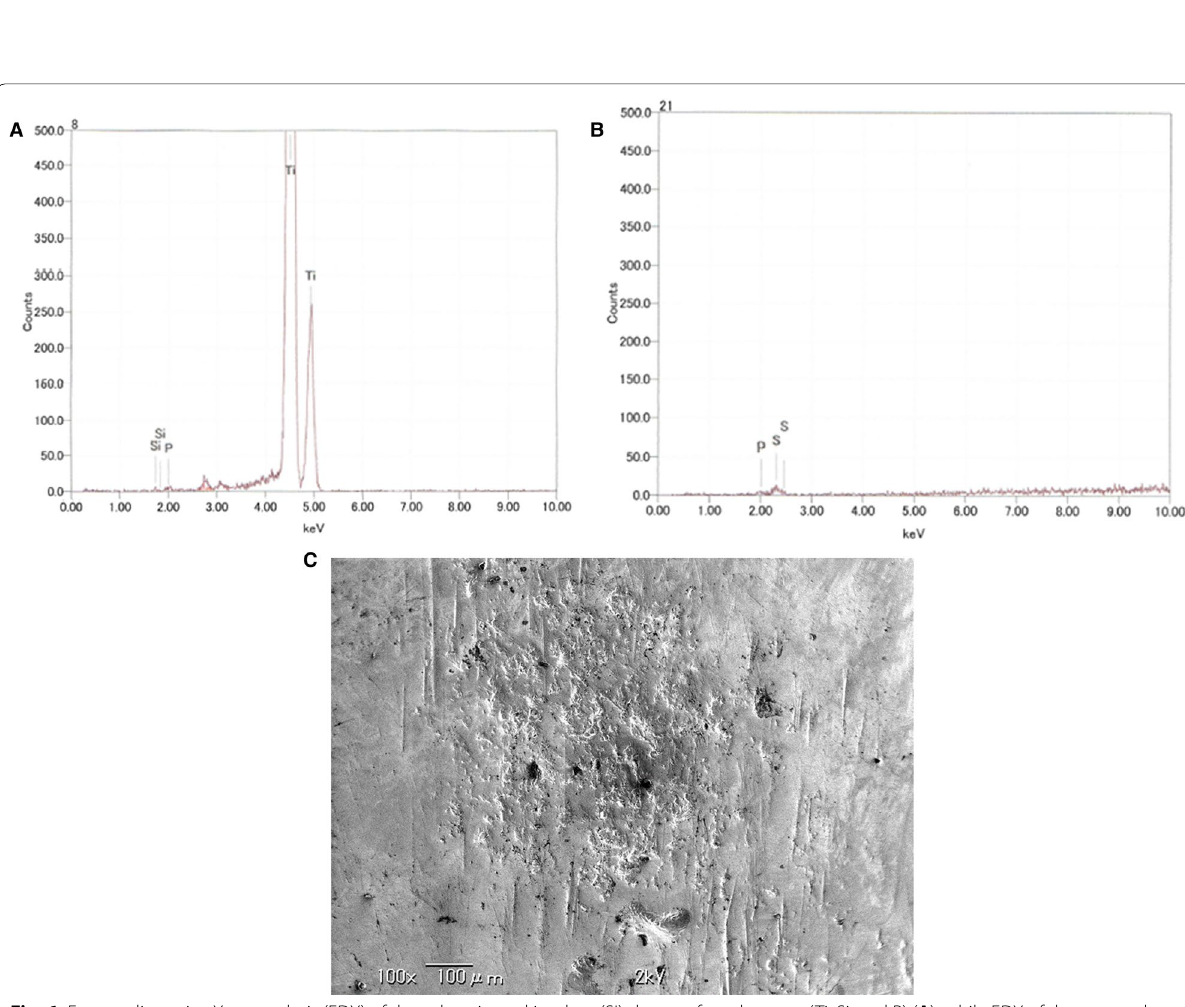
Fig. 6 Energy-dispersive X-ray analysis (EDX) of the subperiosteal implant (SI) shows a few elements (Ti, Si, and P) ( A ), while EDX of the resected specimen shows Si and P, but not titanium ( B ). Scanning electron microscopy of the SI in contact with the squamous cell carcinoma shows a few microcracks ( C